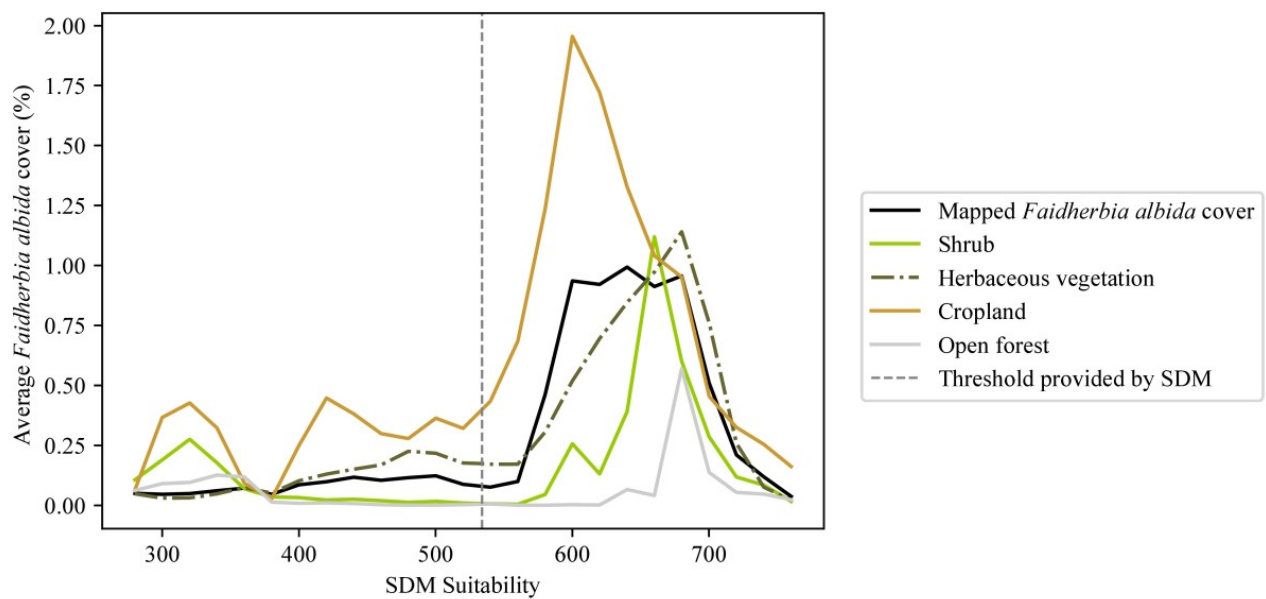
Figure 6. Average Faidherbia albida cover (%) in relation to modelled suitability scores (intervals of 20 units) for different land use/cover types. The land use/cover map of 2019 is provided by Copernicus Global Land Service at 100-m resolution. Wetland, urban, water, bare vegetation and closed forest types were not included in this comparison due to the limited number of observations.